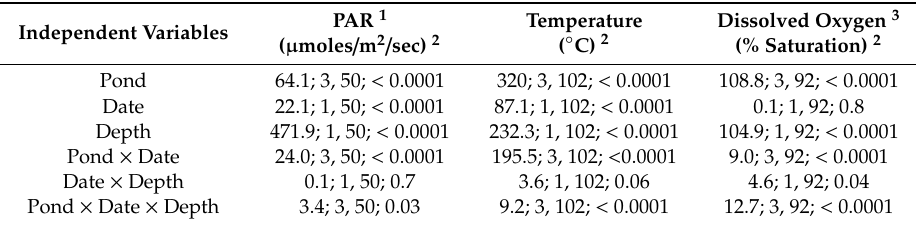
Table 2. ANCOVA results ( F -value, degrees of freedom and probability) for e ff ects of water depth, pond and date of analysis of depth profiles of photosynthetic active radiation (PAR), temperature and dissolved oxygen.